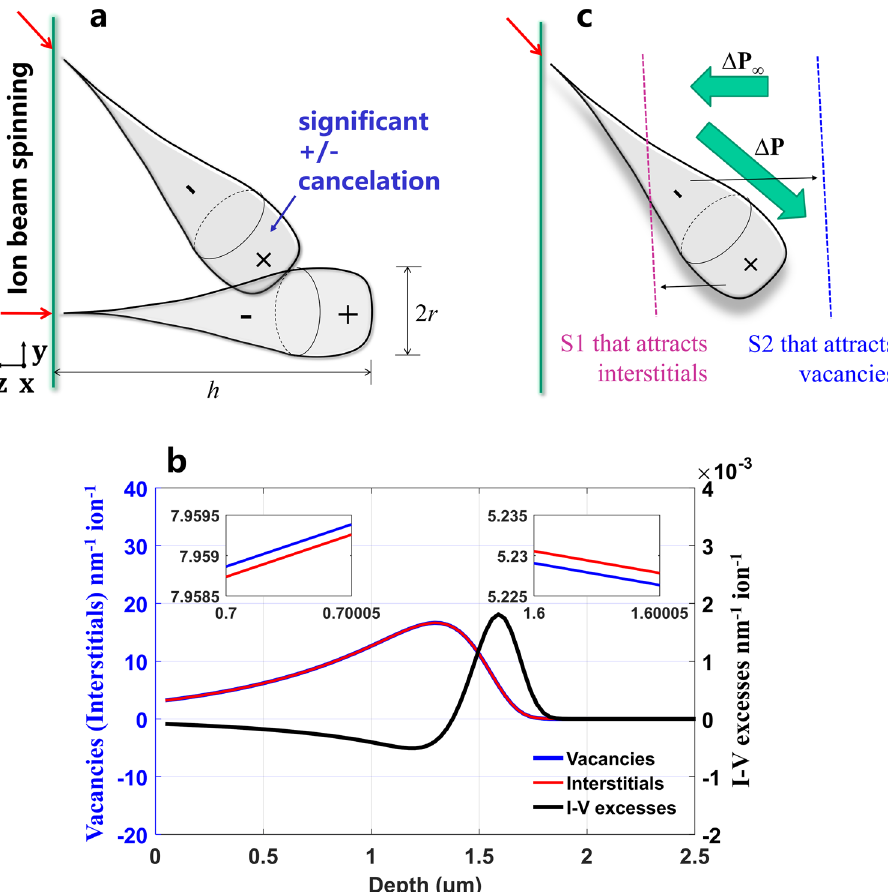
Fig. 2 Illustration of defect imbalance and material ’ s response to it. a Illustration of the cancellation of the positive- p ( x ) region with negative- p ( x ) region by spinning the sample. The black contours illustrate the region of signi fi cant defect concentration generation from SRIM/IM3D MC calculations. b The depth pro fi les of vacancies, interstitials and I-V net excesses for self-ion irradiation in iron with ion energy of 5 MeV and normal incidence, computed by IM3D. c Illustration of the material ’ s response with the in fl uence of material anisotropy. The initial mass fl ow Δ P induced by Z 1 hit at t = t P may not be same as the fi nal mass fl ow Δ P ∞ at t ¼ t P þ τ owing to the sink biases (S1 may attract interstitials, whereas S2 may attract ion hitting. For standard accelerator-based ion-beam irradiation with the beam pointing along the z direction, we could have a large swath (millimeters in x and y , which is the broad ion-beam spot size ( σ i ), and microns in z , which is the ion-projected range) of DPA-exposed contiguous region with p ð x Þh i < 0 or p ð x Þh i > 0, as the “ − ” and “ + ” regions shown in Fig. 2a. For example, the depth pro fi les of PRDs including vacancies and interstitials, estimated from the benchmark calculation of self-ion irradiation in iron with ion energy of 5 MeV and normal incidence, are shown in Fig. 2b. It shows that the contiguous “ + ” region locates deeper than the “ − ” region from the depth pro fi le of I-V net excesses (black solid line).